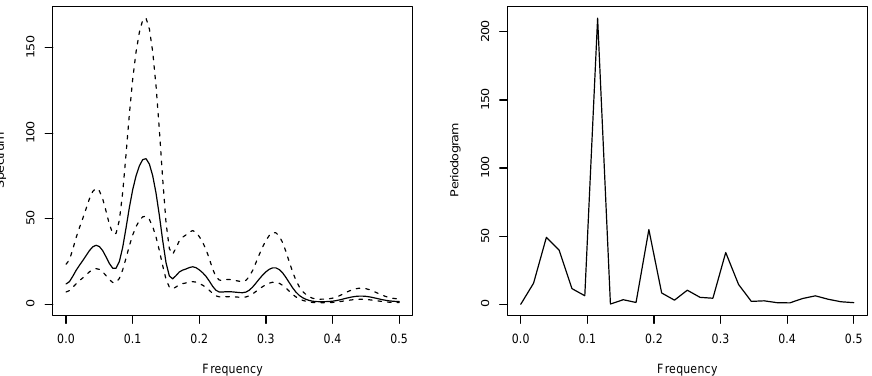
Figure 2. Direct smoothed spectral estimation with Bartlett–Priestley window and approximate confidence intervals ( left ), and scaled periodogram ( right ) for the detrended annual loss